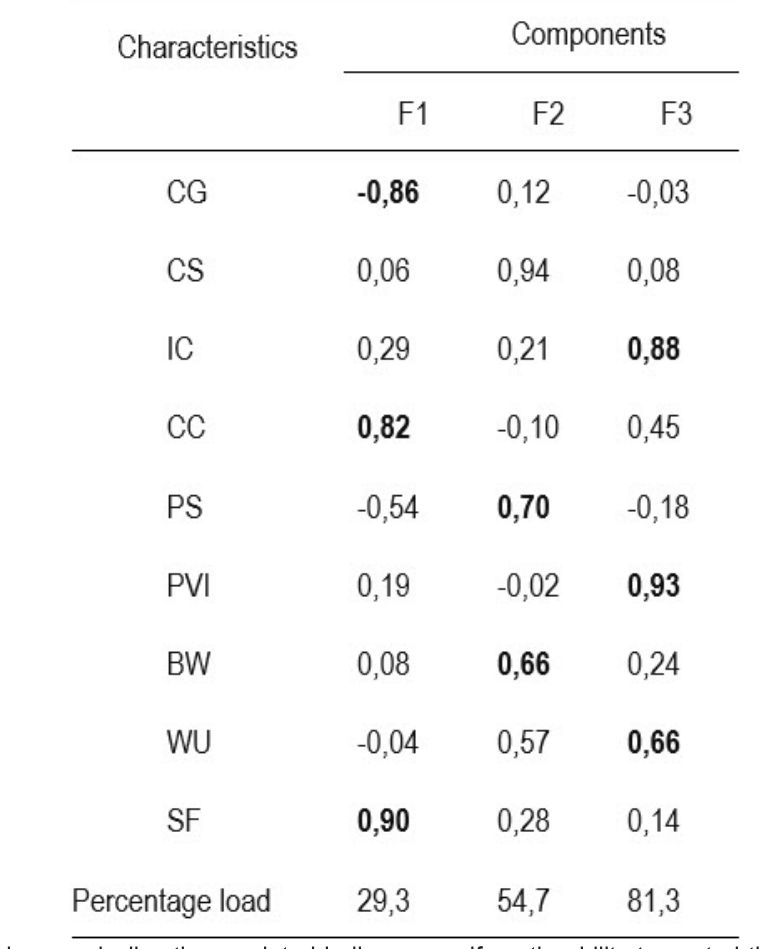
Factor structure of the students’ semantic, categoric and conceptual abilities indices coherence with their basic beliefs ones (group 4 - with high